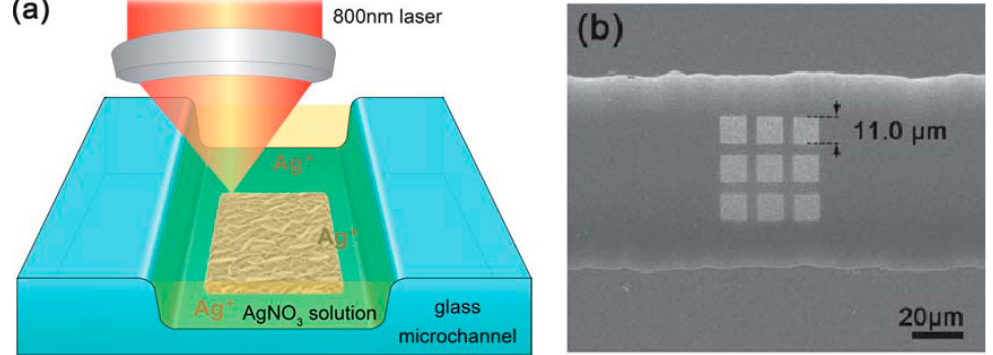
Figure 28. ( a ) Illustration of the laser writing method used to fabricate SERS substrates in microfluidic circuits; ( b ) SEM image of the SERS substrates integrated in the microfluidic channel. Reproduced with permission from Xu et al. [345]. Copyright (2011), the Royal Society of Chemistry.